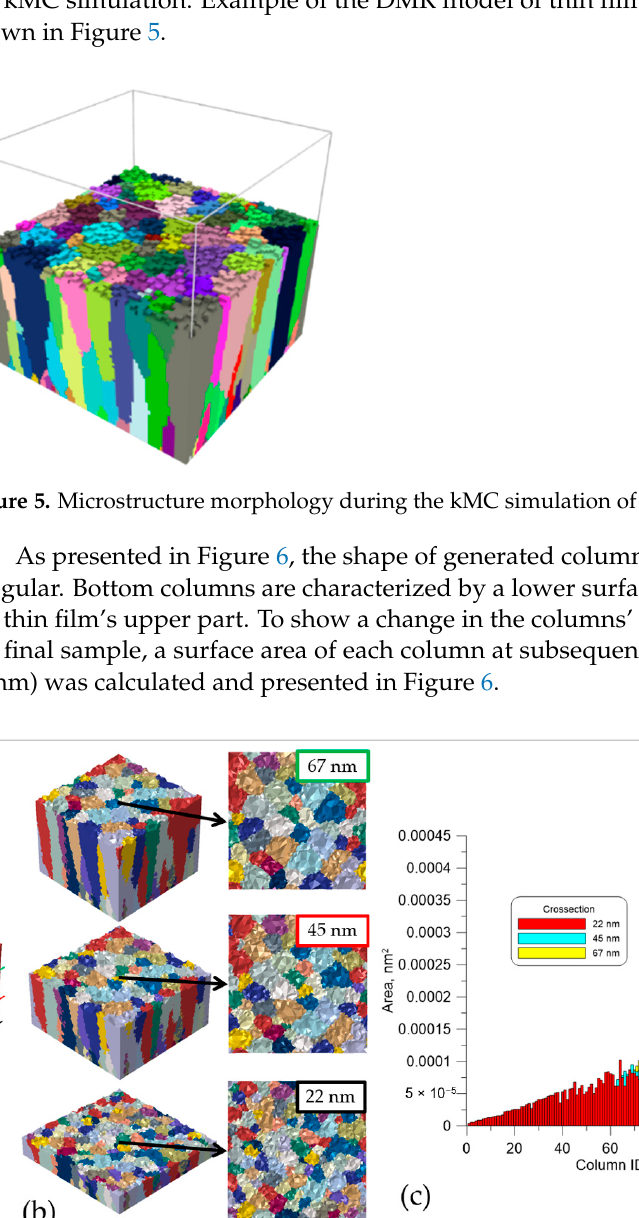
Figure 6. ( a ) position of the cross-section in the final DMR sample, ( b ) illustration of columns at particular cross-sections, and ( c ) diagram representing areas of subsequent columns at particular cross-sections.